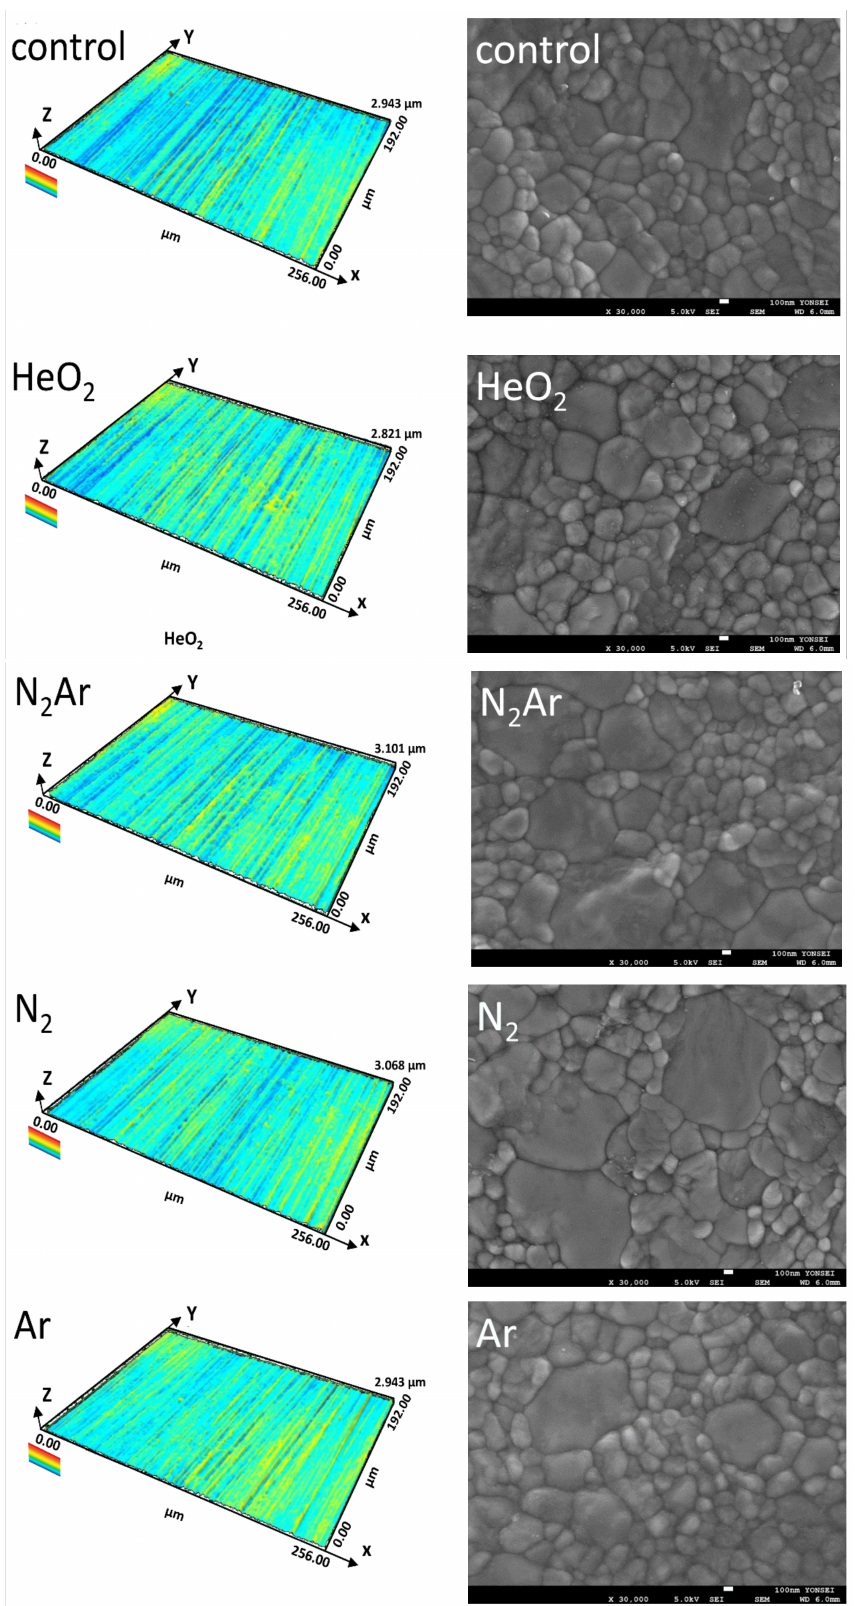
Figure 5. Representative three-dimensional images obtained by confocal laser-scanning microscopy ( left ) and scanning electron microscopic images at 30,000 × magnification ( right ) of each